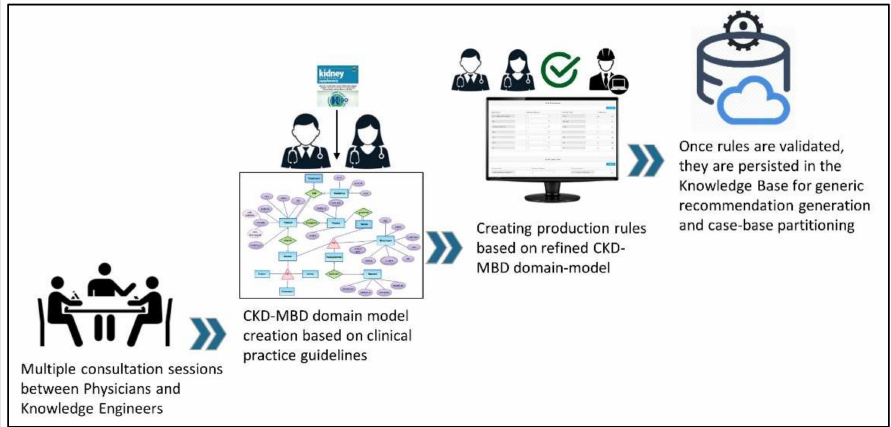
Figure 6. A simplified process for domain-model construction based on clinical practice guidelines for CKD–MBD